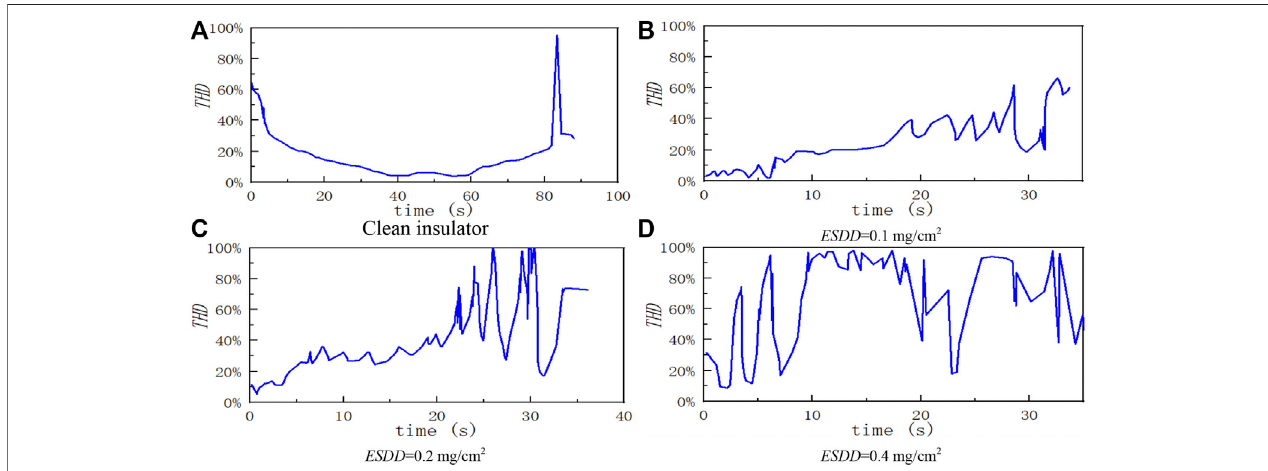
FIGURE 6 | Curves of THD of insulators under different pollution conditions.